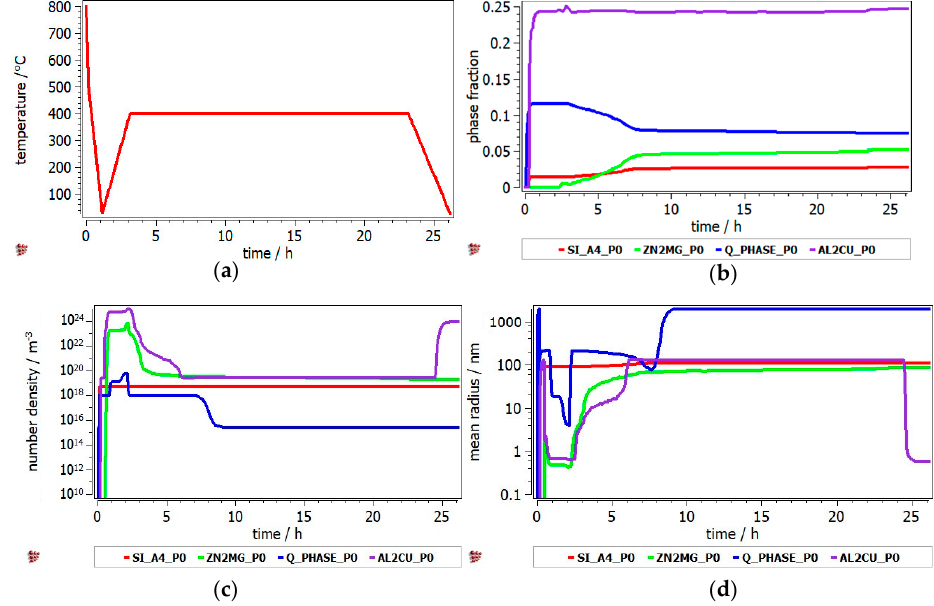
Figure 10. Precipitation kinetics in Al 3.4 Cu 0.5 Si 0.2 Zn 0.5 Mg 0.2 alloy during annealing at 400 ◦ C, for 2 h: ( a ) heat treatment diagram, ( b ) precipitate phase fraction versus time, ( c ) precipitate number density versus time, ( d ) precipitate mean radius versus time.